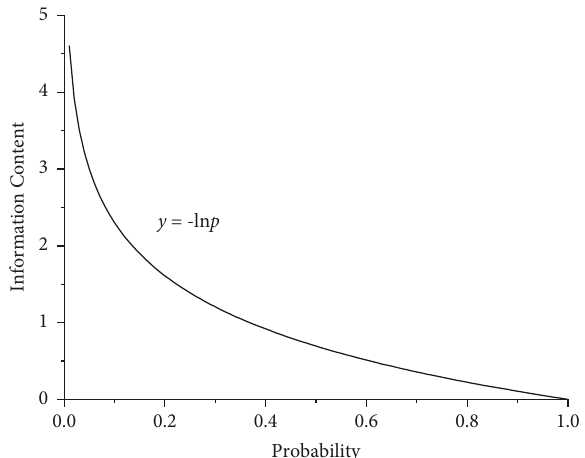
Figure 9: Diagram of the relationship between probability and information content.